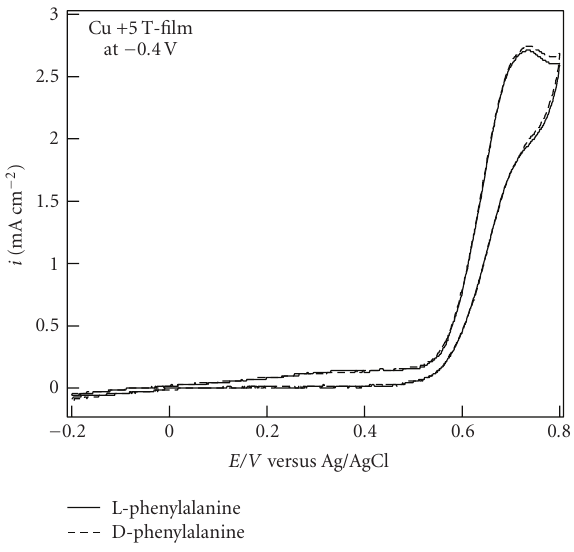
Figure 7: CVs of 20mM L- and D-phenylalanines on the Cu +5T- film electrodes in a 0.1MNaOH aqueous solution. The potential sweep rate was 10mVs − 1